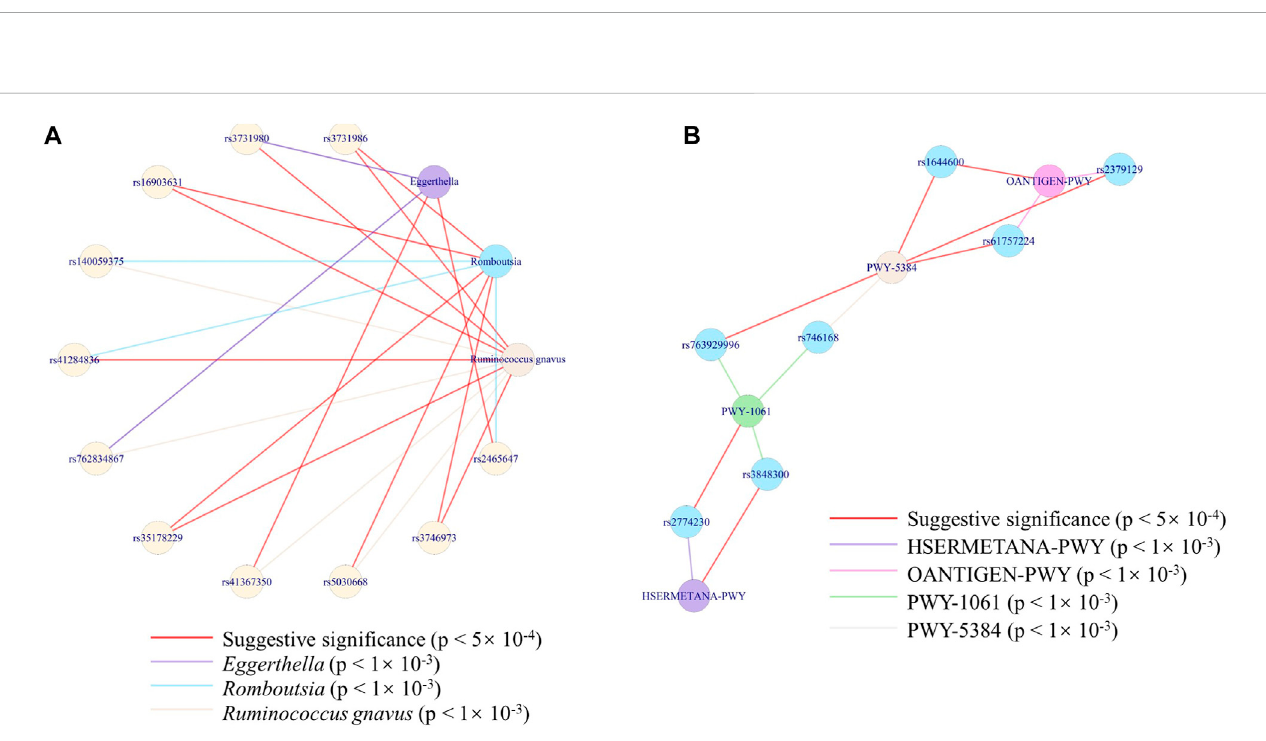
FIGURE 5 Manhattan plot of the associations with SNPs and the features (beta diversity, Actinobacteria , and PWY-5913).